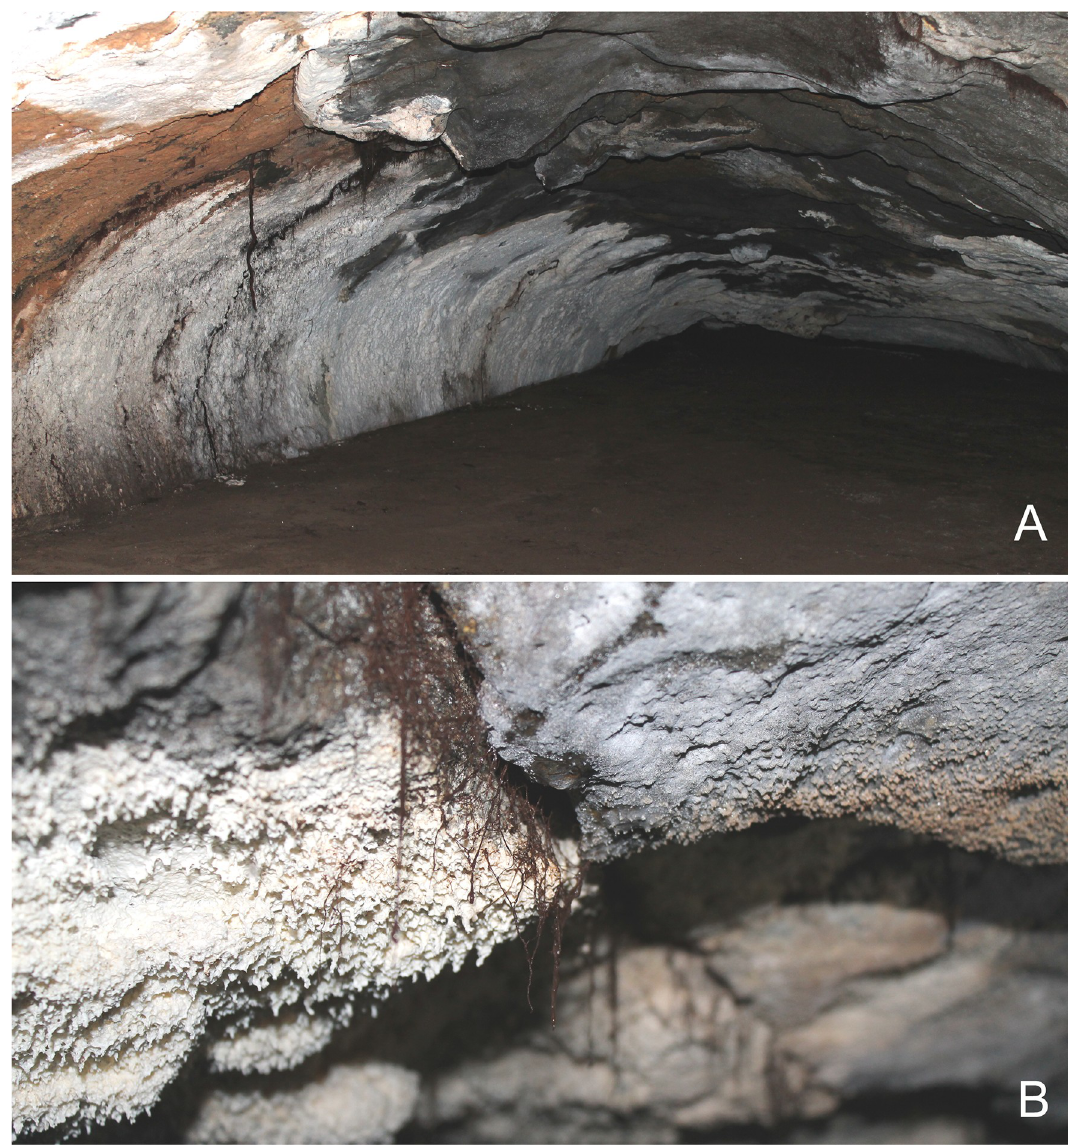
Fig 11. Hypogean environment in Do ñ a Otilia cave. A: General view in the 2Q section of the cave (at about 350 m from the entrance); large roots can be observed hanging on the left side. B: Detail of speleothems and roots of epigean plants emerging through fissures on the ceiling and the